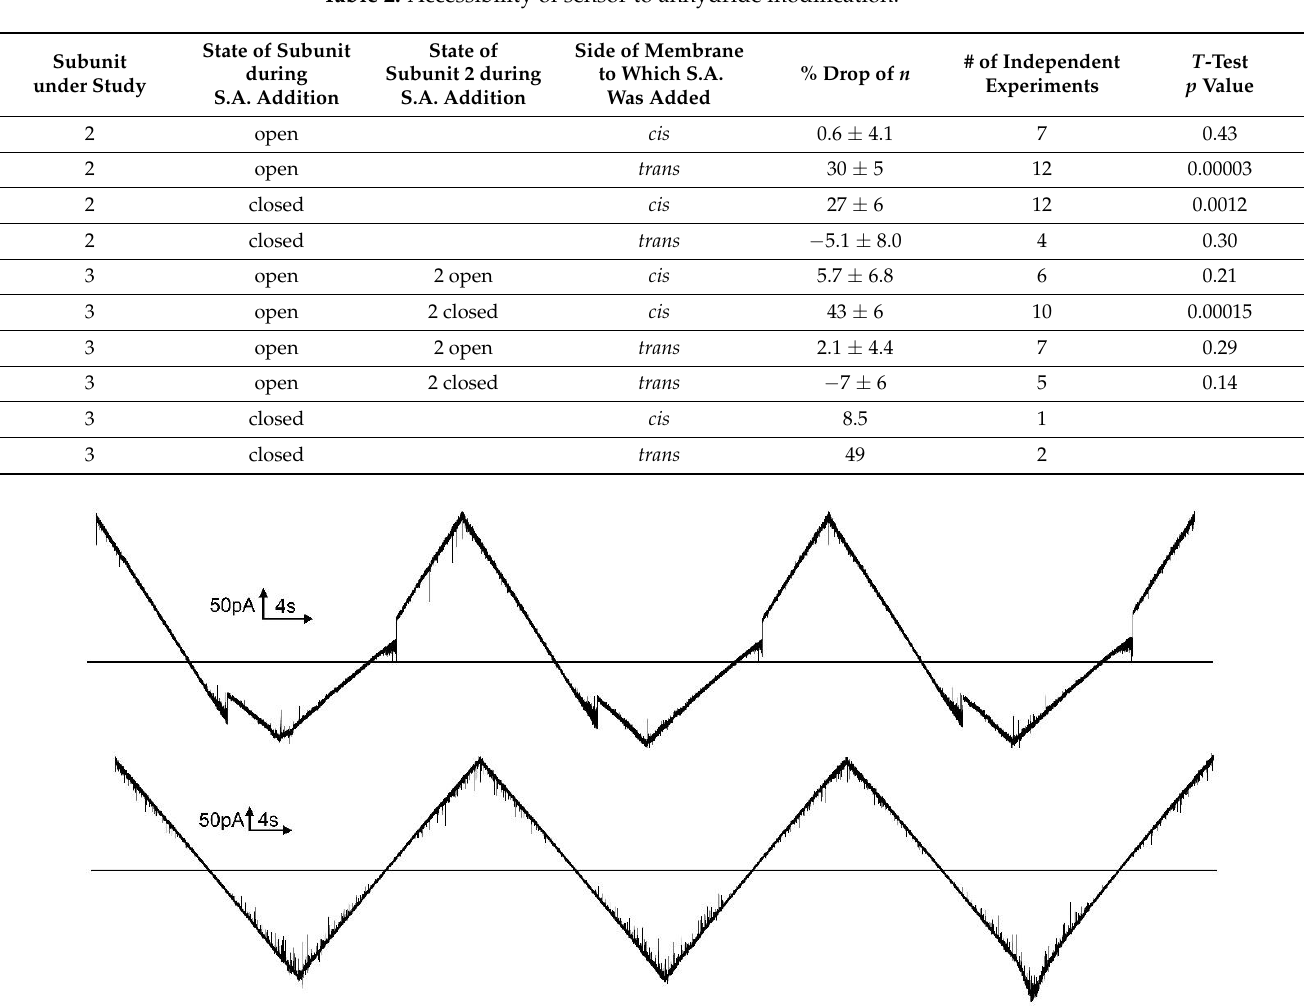
Table 2. Accessibility of sensor to anhydride modification.